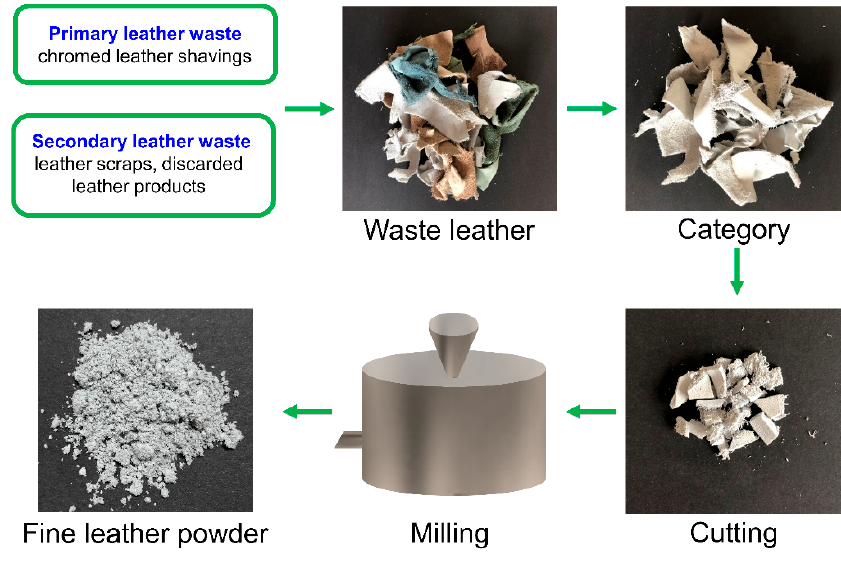
Figure 2. Preparation procedure for the CL powder.